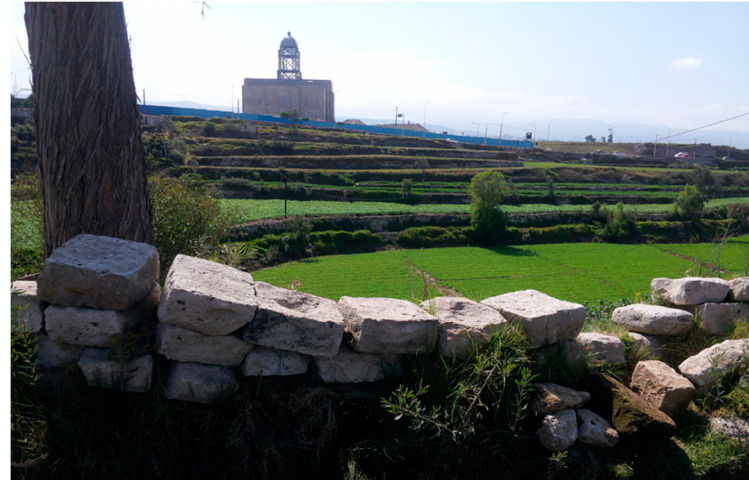
Figure 7. An unfinished Arequipa temple sits atop pre-Inca terracing that the Yarabaya people built over 3000 years ago. February